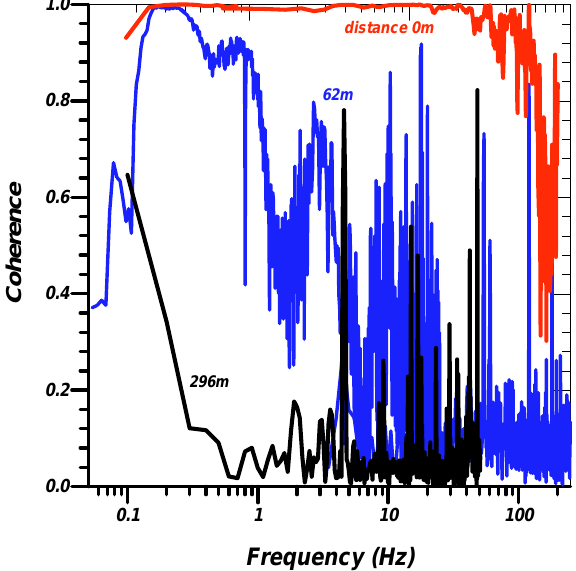
FIG. 7. (Color) Power spectral densities of vertical vibrations of the Tevatron quadrupole magnet (upper curve), the main ring tunnel floor, and on the surface at E4 (lower curve).